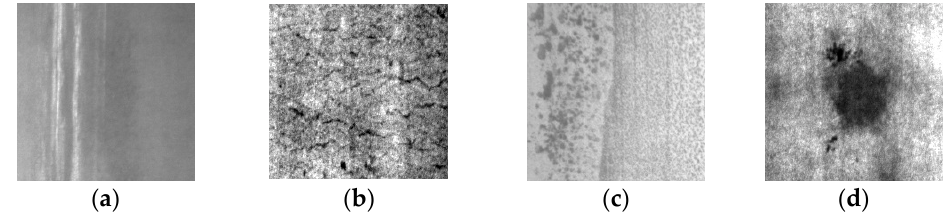
Figure 2. Four types of defects: ( a ) the nick type; ( b ) the crack type; ( c ) the blister type; ( d ) the spot type.